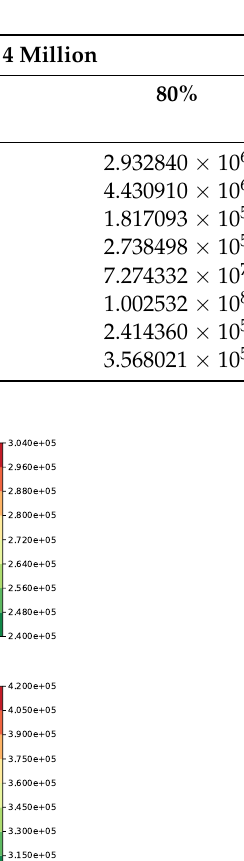
Table 6. Impact of the inoculation rate (Vac.) and the efficacy ( (cid:101) ) of the vaccine on the peak of the infected (I) and hospitalized (H) subpopulations. In addition, on the deaths (D) and recovered (R) cases. In these scenarios, the infectiousness of the asymptomatic individuals relative to symptomatic is 75% ( β A = β I ), and the percentage of infections that are asymptomatic is 40%.